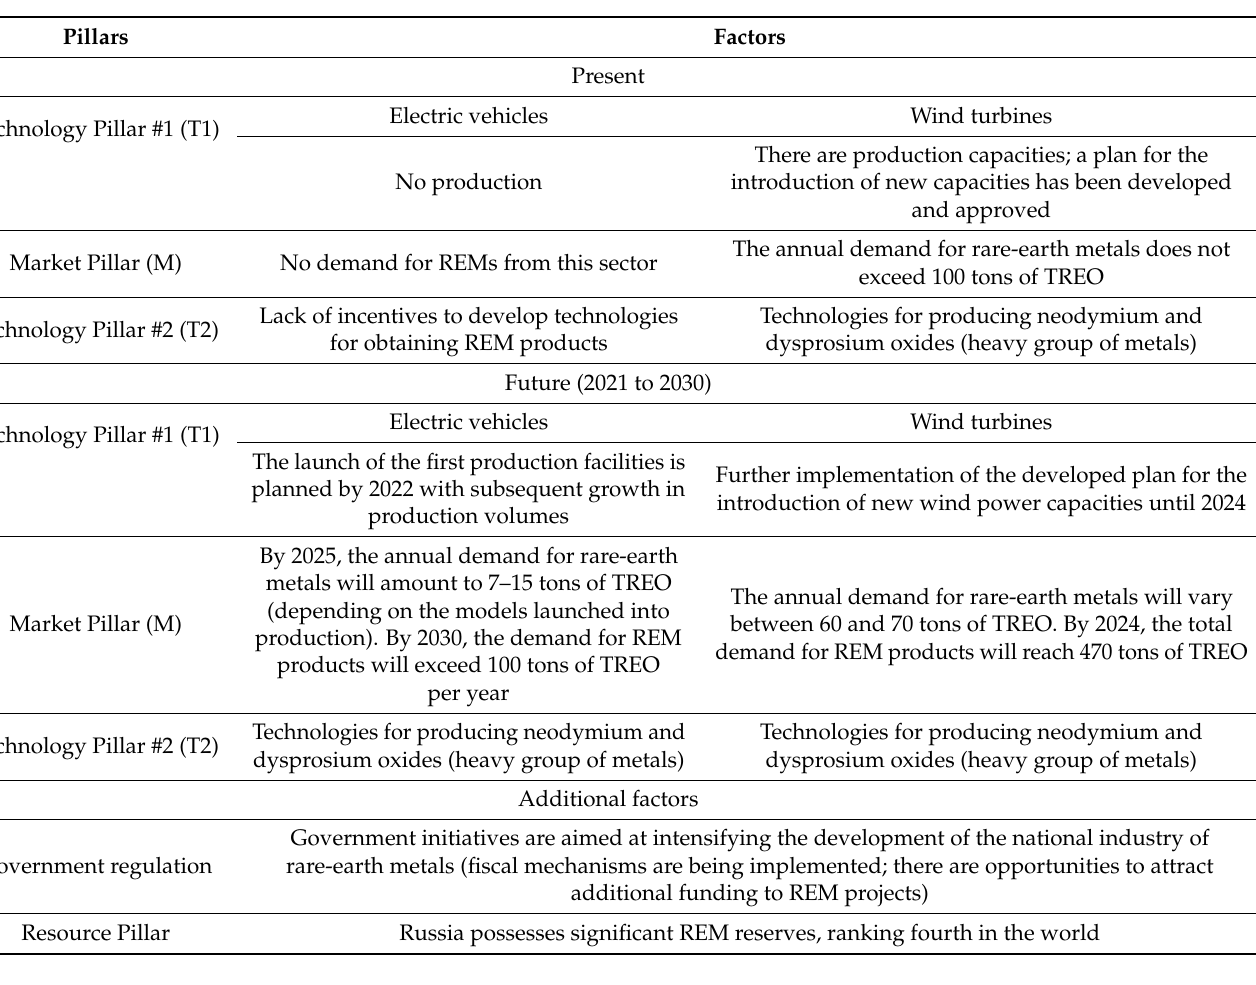
Table 5. Analysis of the prospects for the development of the rare-earth metal industry in Russia in the context of green technology production.